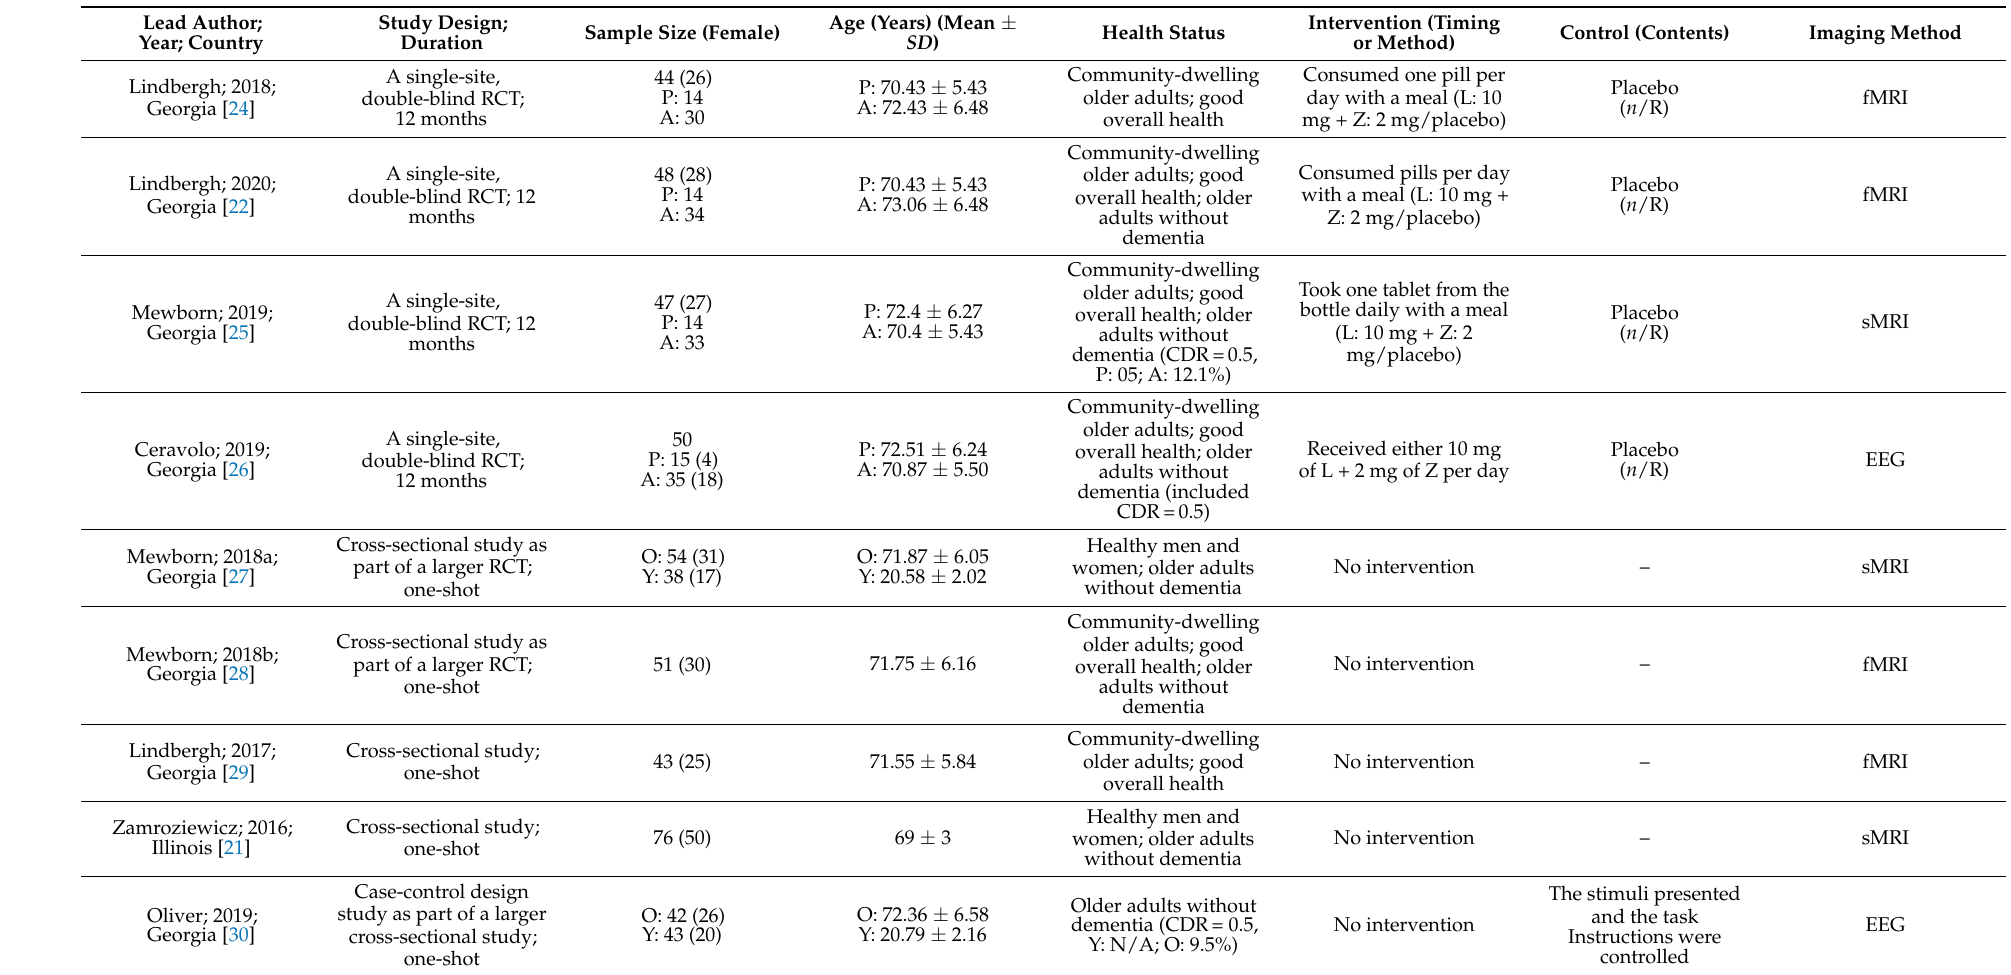
Table 1. Studies